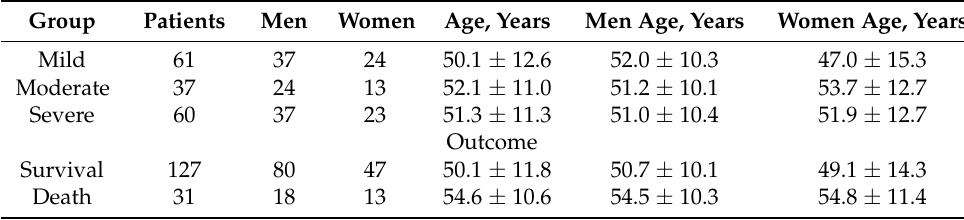
Table 1. Distribution of patients by severity and outcome of COVID-19 infection.